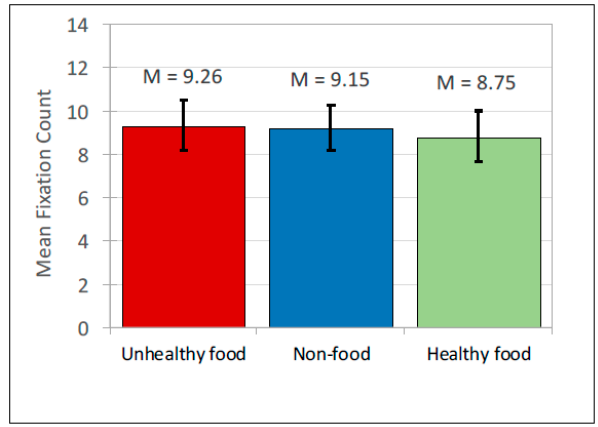
Figure 10. Fixation count: Mean scores.